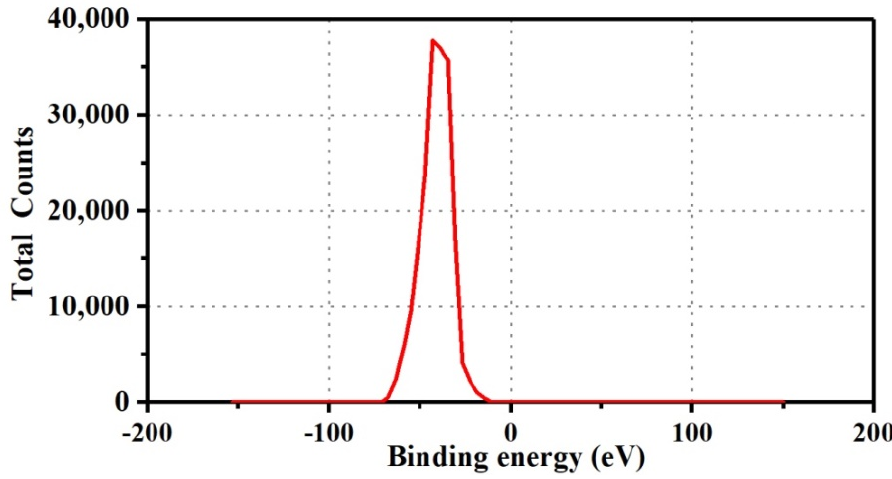
Figure 4. Potential diagram of Ag NPs.